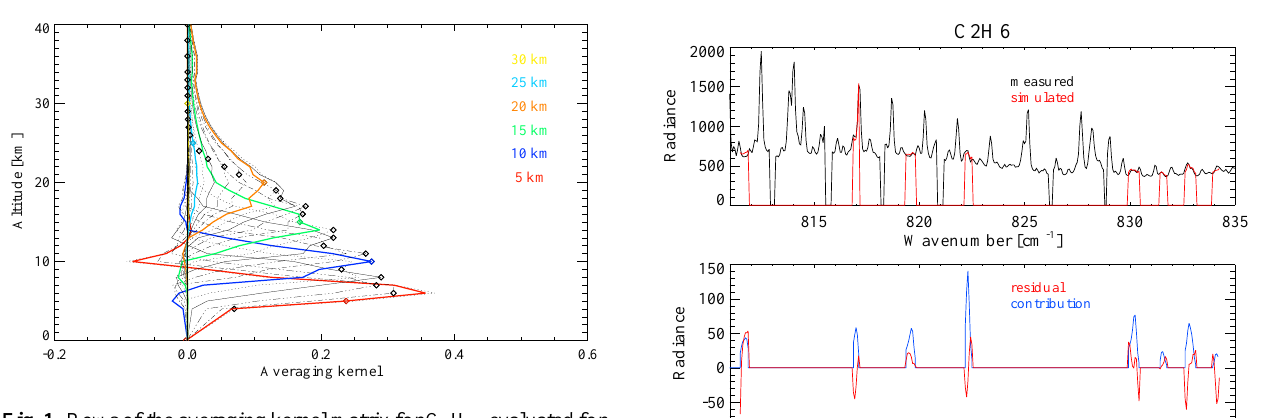
Fig. 1. Rows of the averaging kernel matrix for C 2 H 6 , evaluated for a limb scan recorded at 80 ◦ S, 162 ◦ E on 10 October 2009. Selected nominal altitudes are highlighted by colours. Table 2. Microwindows and upper altitude limits (in brackets) for MIPAS reduced resolution nominal mode retrievals (cm − 1 ).